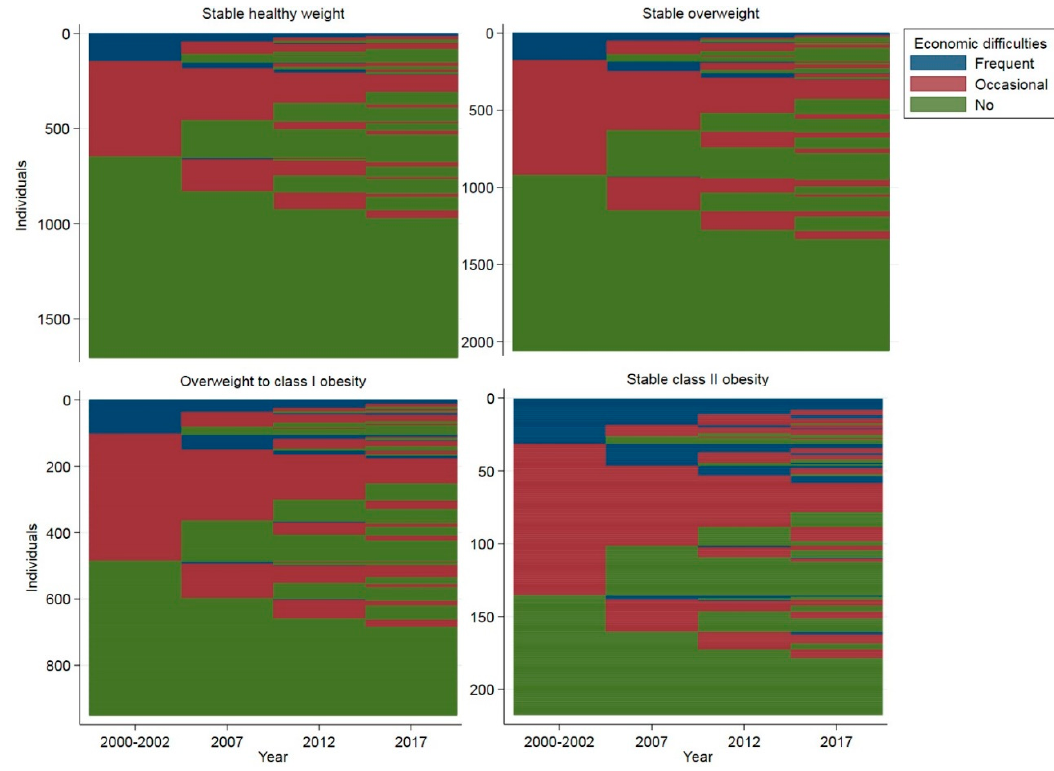
Figure 3. Sequence index plots of household income by the body mass index (BMI) trajectory groups: individual-level sequences in household income quartiles visualized over the follow-up. The y-axis includes all the individual observations within a BMI trajectory group, and the x-axis demonstrates the follow-up time. Each participant’s household income level sequence has been drawn in a horizontal line. Table 3. Characteristics of sequences in current economic di ffi culties by the body mass index (BMI) trajectory groups over the follow-up